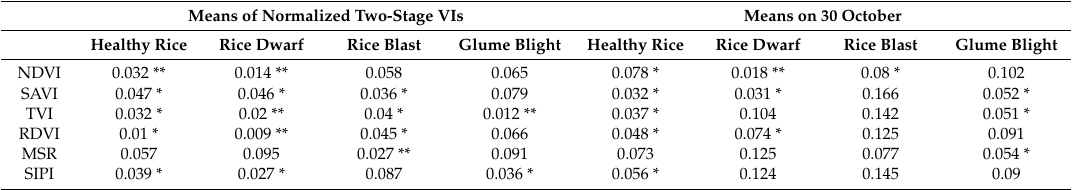
Note: * indicates the different significance at 0.95 confidence level. ** indicates the different significance at 0.99 confidence level.